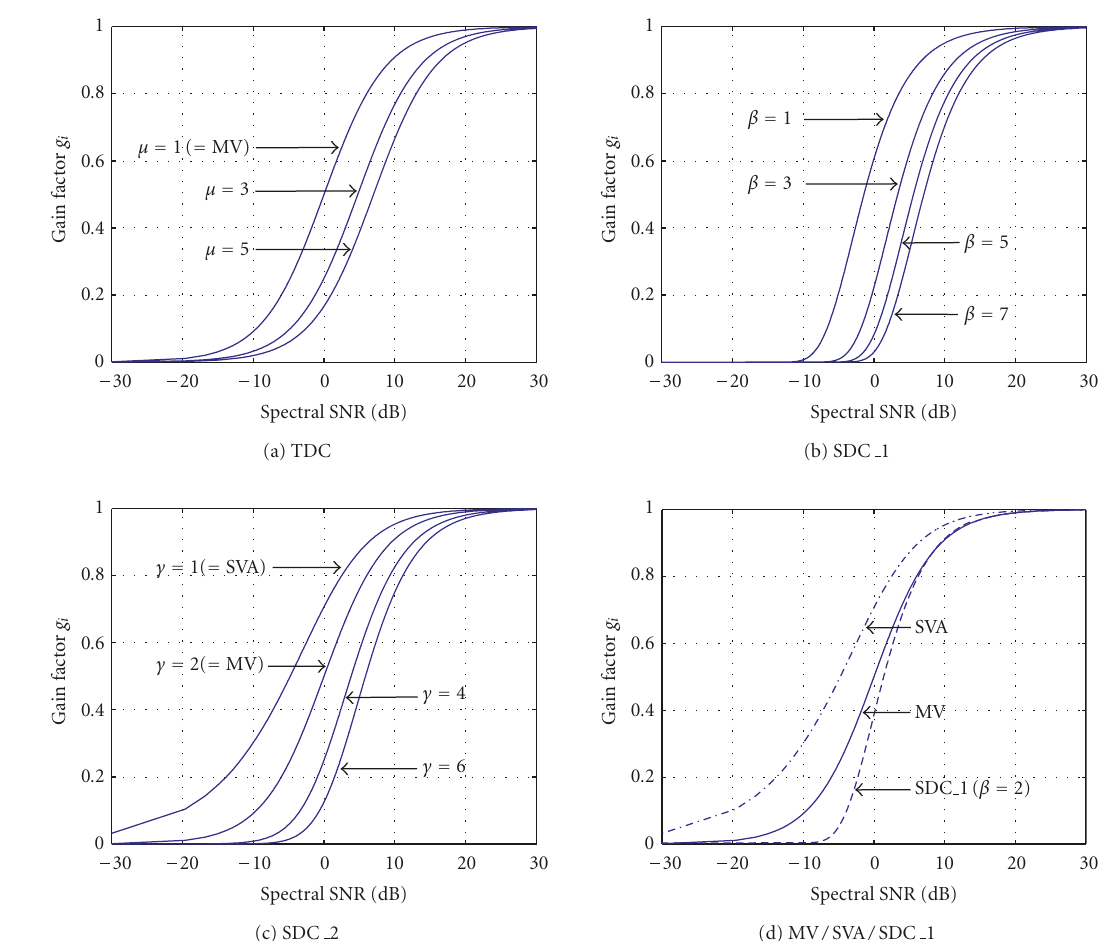
Figure 2: Gain factors for the di ff erent estimators as a function of the spectral